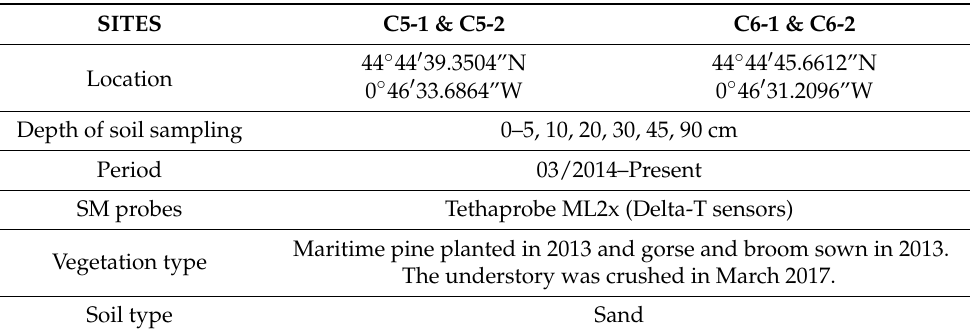
Table 3. The main characteristics of the Hermitag